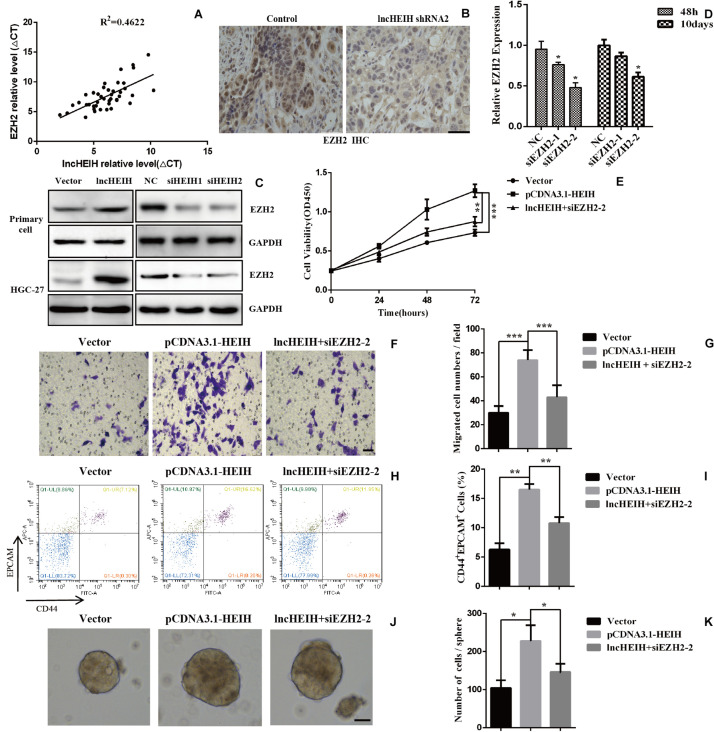
LncHEIH promotes gastric cancer progression by upregulating EZH2. (A) LncHEIH and EZH2 mRNA levels in paired gastric cancer tissue samples and correlation analysis. Data were normalized to GAPDH expression. (B) The tumor sections were subjected to IHC staining using antibodies against EZH2 (scale bars = 50 μm). (C) Immunoblot showing EZH2 protein levels in gastric cancer cells transfected with lncHEIH or si-lncHEIH for 48 h. (D) EZH2 mRNA levels in primary gastric cancer cells transfected with siEZH2. (E) CCK-8 analysis determined the viability of primary gastric cancer cells transfected with lncHEIH and siEZH2-2. (F,G) Transwell assays were used to determine the migration ability of primary gastric cancer cells transfected with lncHEIH and siEZH2-2 (scale bars = 50 μm). (H,I) Percentage of CD44+ EPCAM+ CSC among primary gastric cancer cells transfected with lncHEIH and siEZH2-2. (J,K) Representative image of oncospheres and the number of cells per sphere after 10 days (scale bar = 50 μm). Data are shown as the mean ± SD. *P < 0.05, **P < 0.01, ***P < 0.001.